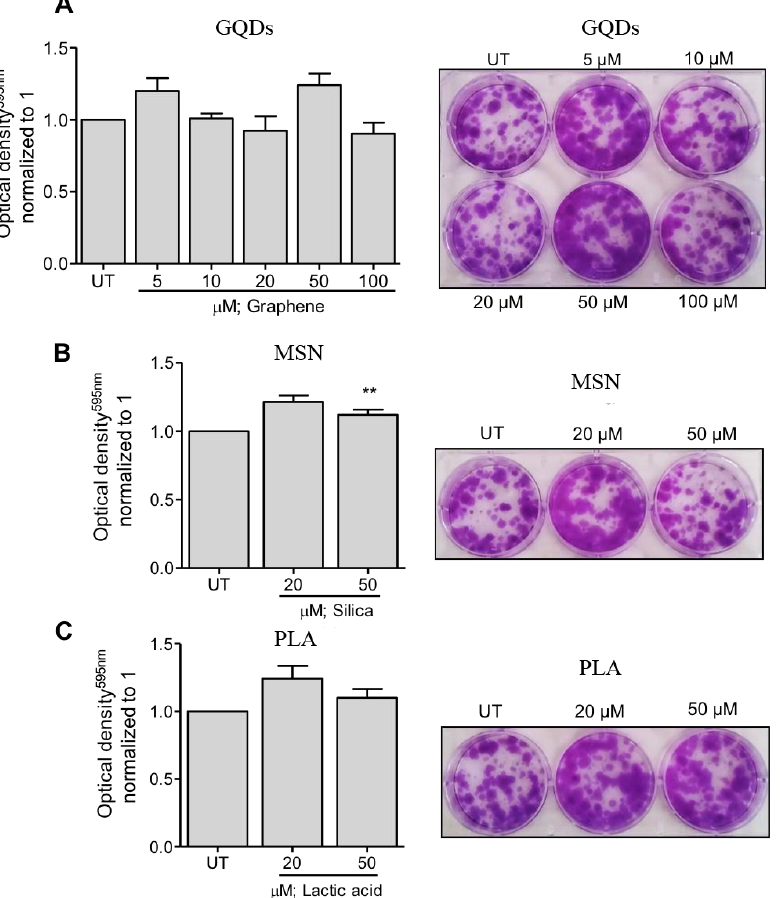
Figure 2. Clonogenicity capacity following treatment of breast cancer cells with a range of ( A ) graphene quantum dots (GQDs), ( B ) mesoporous silica nanoparticles (MSN) or ( C ) polymeric lactic acid (PLA) concentrations. MDA-MB-231 breast cancer cells were treated with nanopolymers for 24 h, after which fresh media was replaced in plates. After colony formation, cells were stained with crystal violet. Colonies were dissolved and optical density was measured at 595 nm. The graphs represent the mean ± standard deviation from three independent experiments. UT: Untreated cells. Statistical significance was analyzed by the Student´s t test (* p < 0.05; ** p < 0.01).